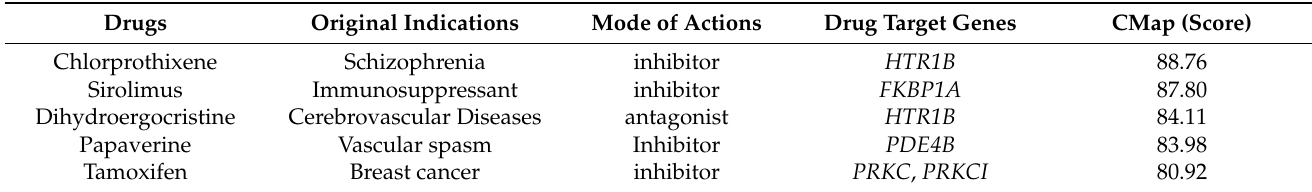
Table 2. The top five drug repositioning candidates for acute lymphoblastic leukemia (ALL) were prioritized based on the CMap comparison to dasatinib.